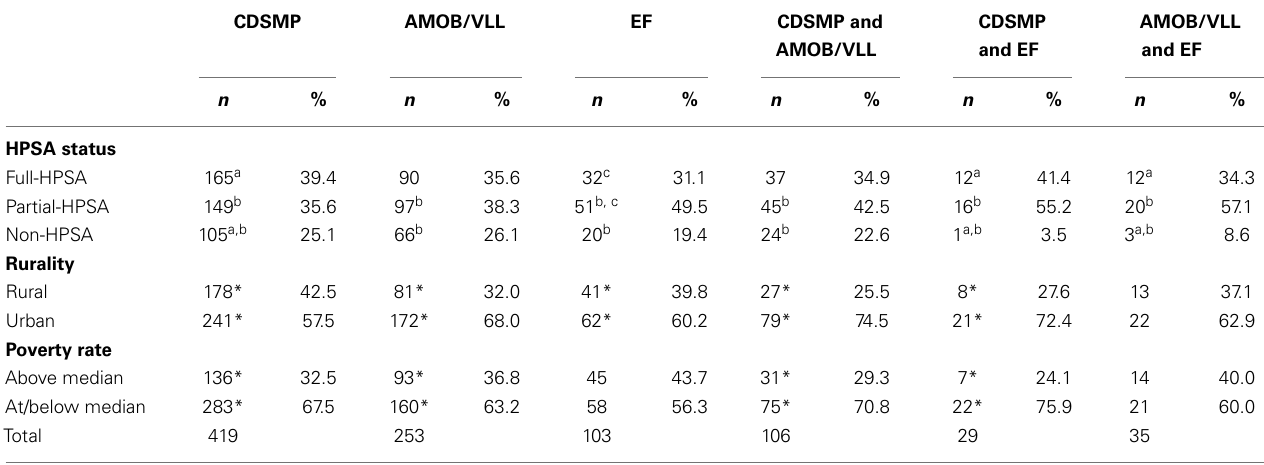
Table 4 | Distribution of counties by availability of evidence-based programs (CDSMP,AMOB/VLL, EF) by health professional shortage area (HPSA), rurality, and poverty status in 2008